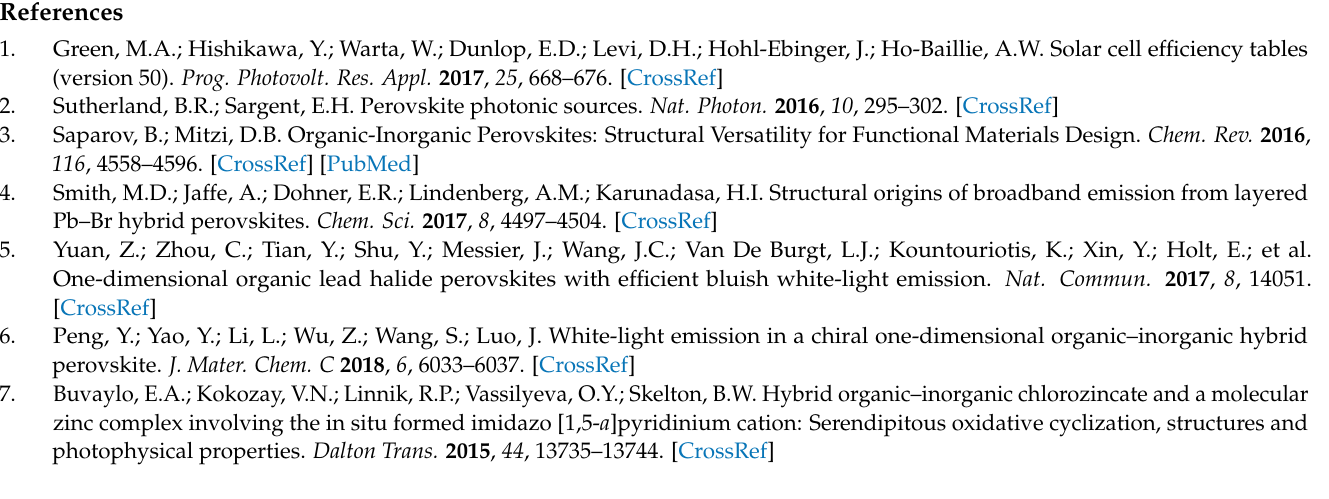
Figure S2: IR spectrum of [PbBr 2 (L2)] n ∞ · 0.5nH 2 O ( 2 ); Figure S3: IR spectrum of [PbBr 2 (L3)] 2 ( 3 ); Figure S4: Selected fingerprint plots of the (N12, N13A) and (N22, N23A, major component) [L1] + cations in the crystal structure of 1 showing X i ··· X e interactions (where X = Cl, O, C or H); Figure S5: Selected fingerprint plots of the fragment [PbBr 2 (L2)] in the crystal structure of 2 showing X i ··· X e interactions (where X = Br, O, C or H); Figure S6: Selected fingerprint plots of the dinuclear molecule of 3 showing X i ··· X e interactions (where X = Br, N, C or H); Figure S7: Reduced density gradient surfaces (isovalue of 0.5) showing weak vdW interactions (green area) between aromatic fragments of the ligands L3 in the molecular structure of 3 (lead and bromine atoms were excluded from